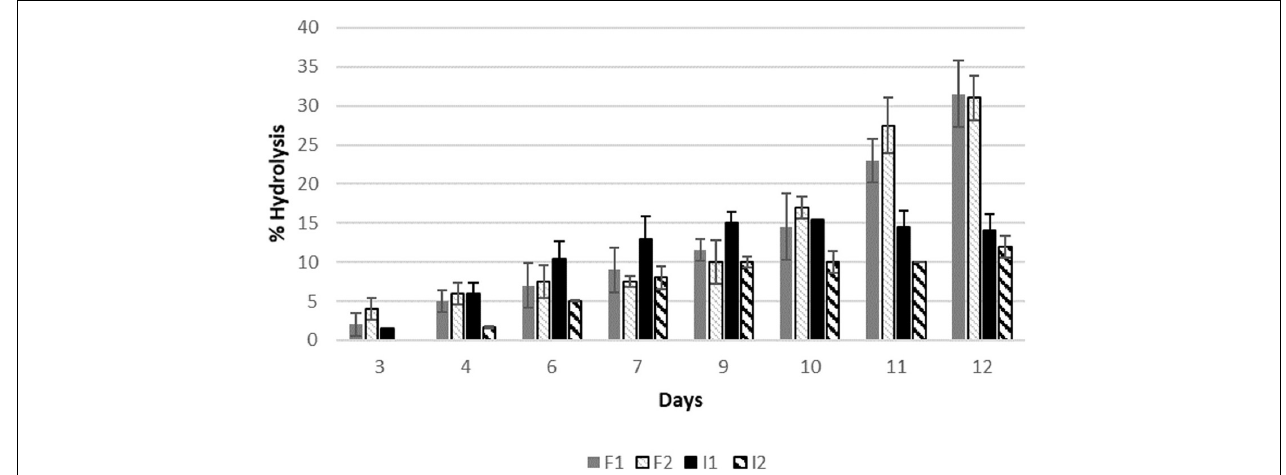
FIGURE 3 | Percentage of aroma precursors hydrolysed by the enzymatic treatment of a glycosidic extract from Muscat must. F1 free enzyme 0.013 g/mL, F2 0.026 g/mL, I1 immobilised enzyme 0.013 g/mL, and I2 immobilised enzyme 0.026 g/mL. TABLE 2 | Concentration of volatile compounds released by free and immobilised β -glucosidases at different doses. Immobilised enzyme Free enzyme Volatile